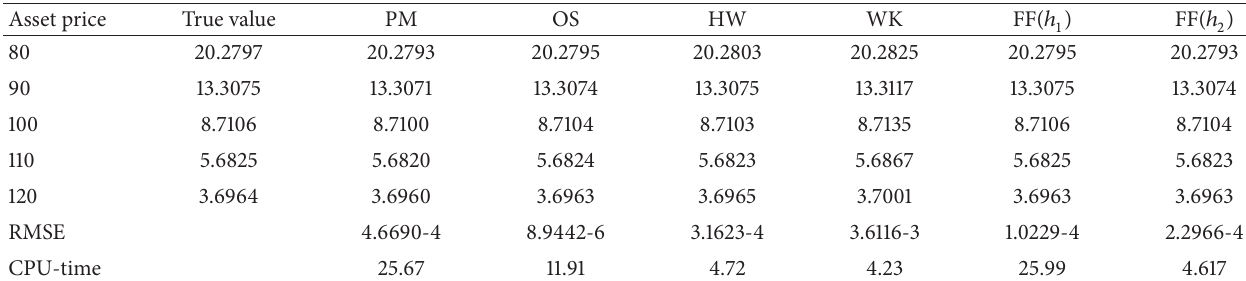
Table 4: Comparison with other methods: put option value for different asset prices.